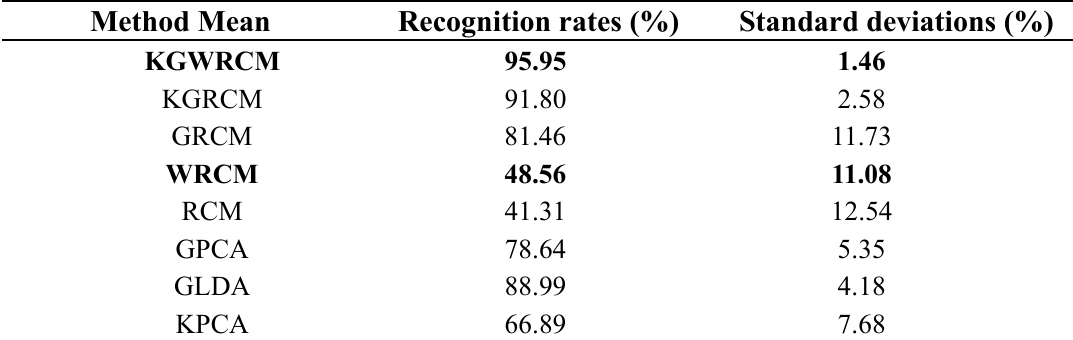
Table 3. The performance of different approaches on the AR face